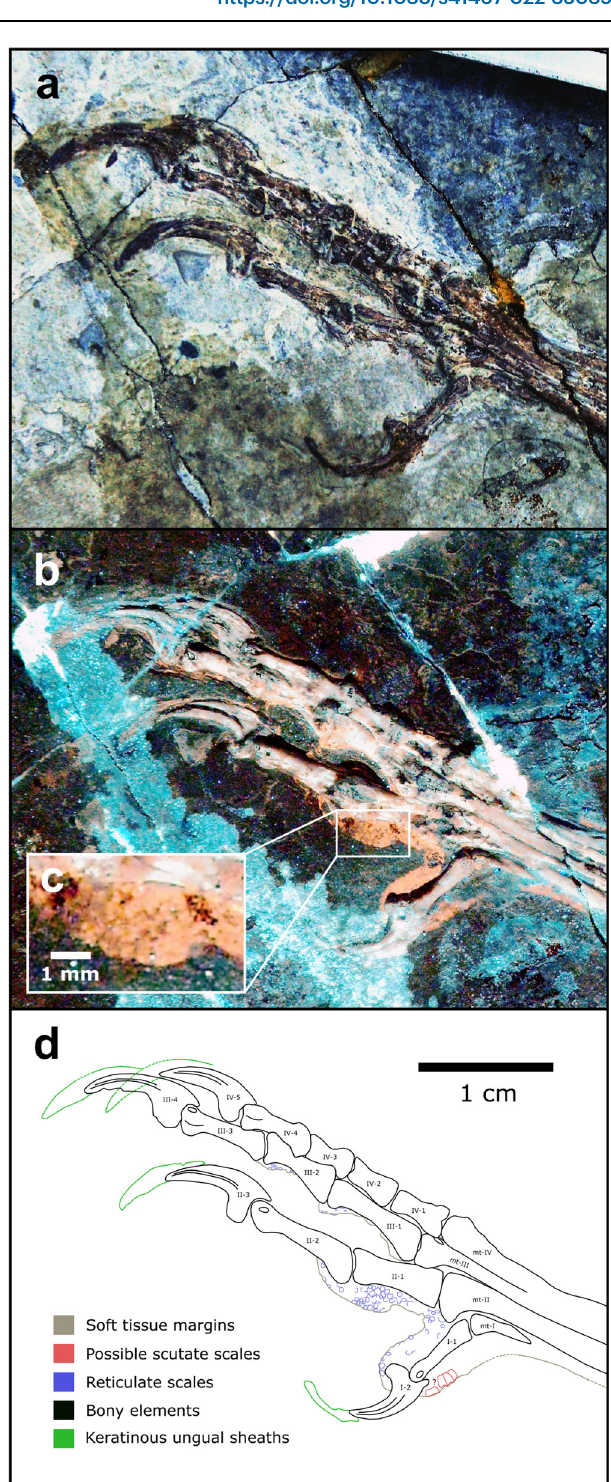
Fig.4|Complete,articulatedrightpesof Confuciusornis STM13-55. Fossilunder a white light and b laser-stimulated fl uorescence. c Close-up of reticulate scales on digit II. d Interpretive drawing, where solid lines indicate preserved structural boundaries, and dashed lines represent assumed or completed